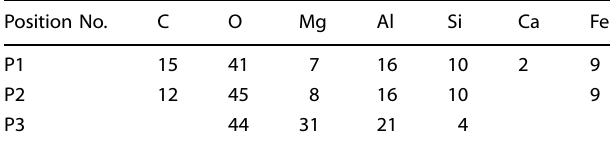
Table 3. Chemical compositions of the marked positions shown in Fig. 5 (in wt%).